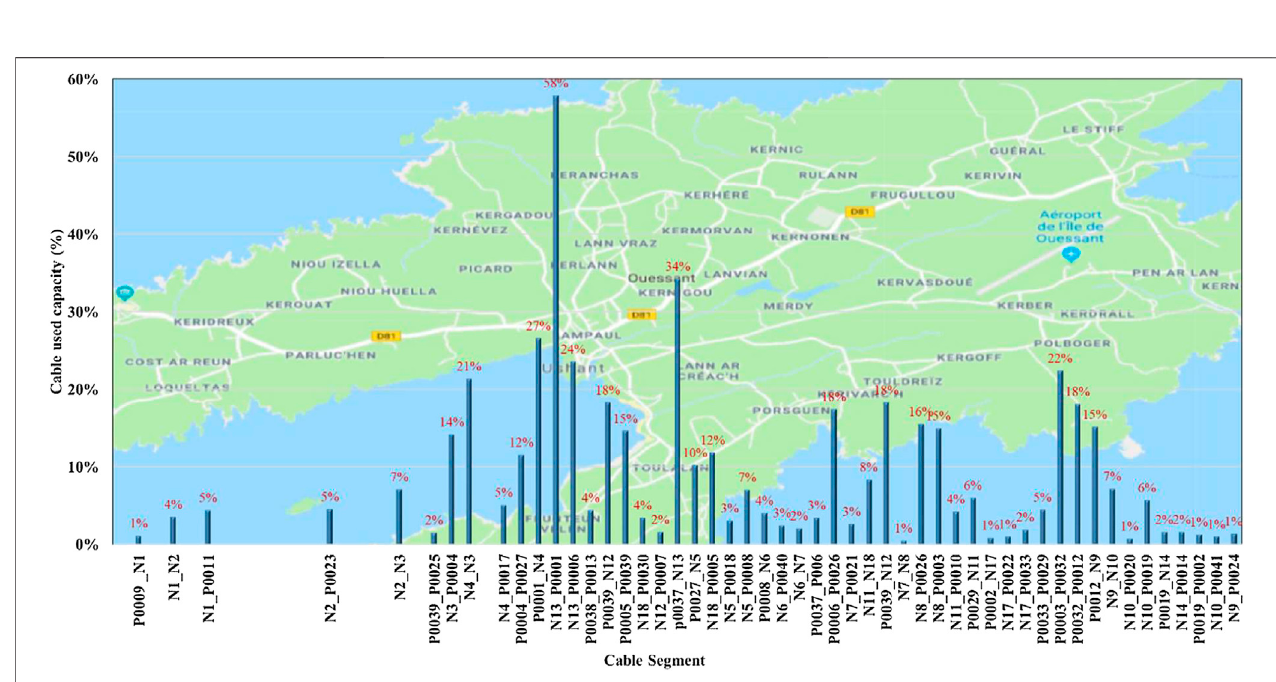
FIGURE 10 | Cable capacity usage under maximum load